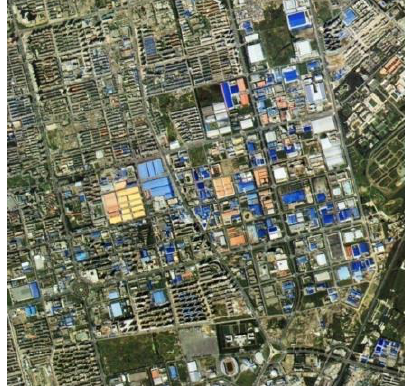
Figure 6. Changchun image taking from multispectral